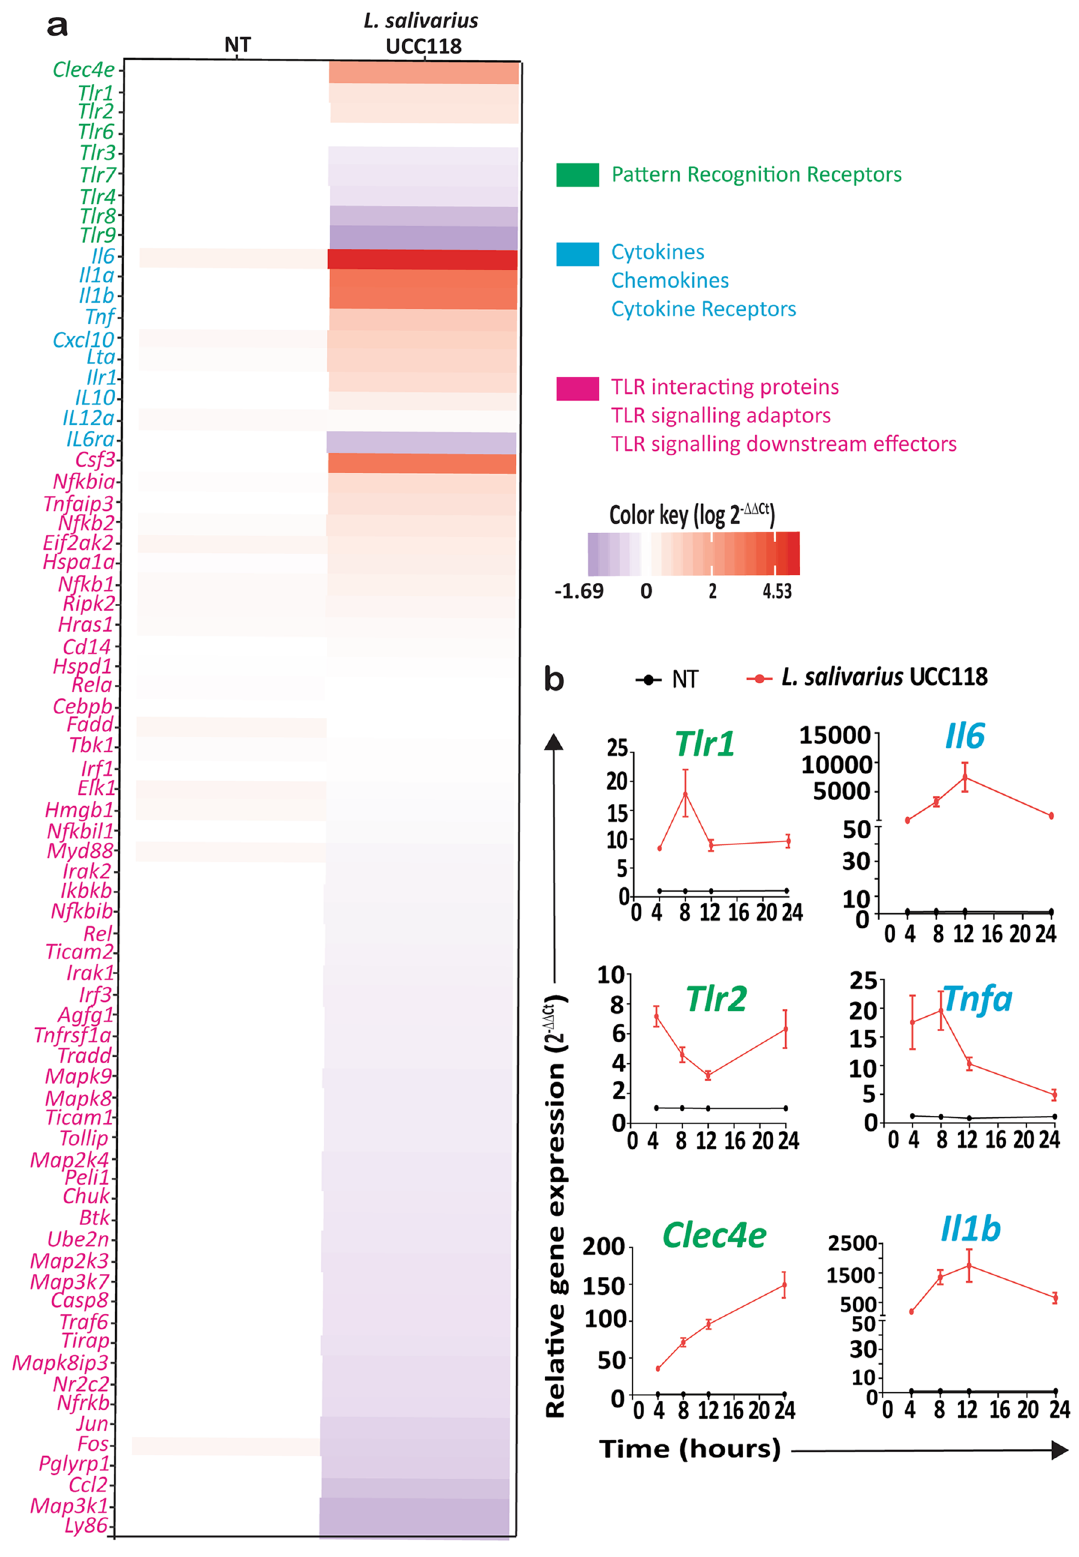
Figure 7. Clec4e is the most upregulated PRR in L. salivarius UCC118 co-cultured BMDMs. ( a ) Heat map represents log values of the relative fold difference in gene expression (log 2 −ΔΔCt ) of genes encoding pattern recognition receptors (green), cytokines and chemokine and cytokine receptors (blue), TLR interacting protein, signaling adaptors and downstream effectors (pink). WT BMDMs were either non-treated (NT) or cocultured with L. salivarius UCC118 at MOI of 10 for 20 h. ( b ) Relative fold expression of PRRs Tlr1 , Tlr2 and Clec4e and cytokines Il6 , Tnfa and Il1b at 4, 8, 12 and 24 h in BMDMs that were either non-treated (NT) or cocultured with L. salivarius UCC118. Relative gene expression data of genes in both ( a ) and ( b ) are the average of three independent experiments (n = 3) normalised to relative expression of housekeeping gene Actb (beta-